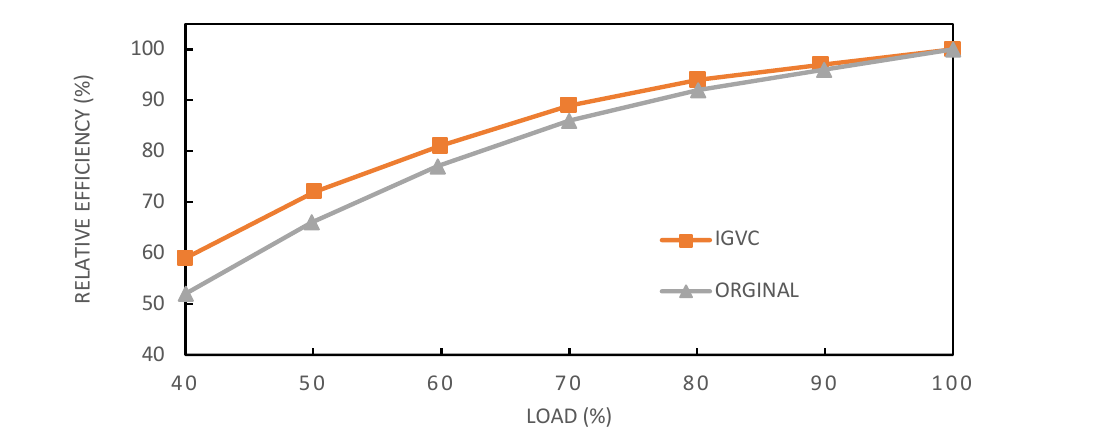
Figure 4. Relative efficiency optimization